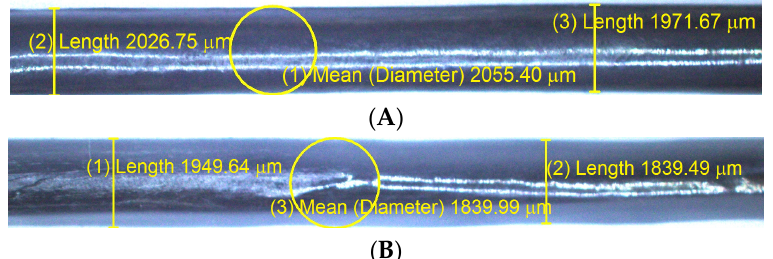
Figure 18. The diameter of the confirmed test specimen: ( A ) melt temperature: 190 °C; ( B ) melt temperature: 230 °C.